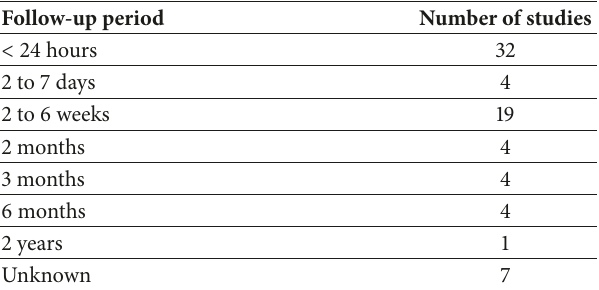
Table 15: Follow-up period in included studies.